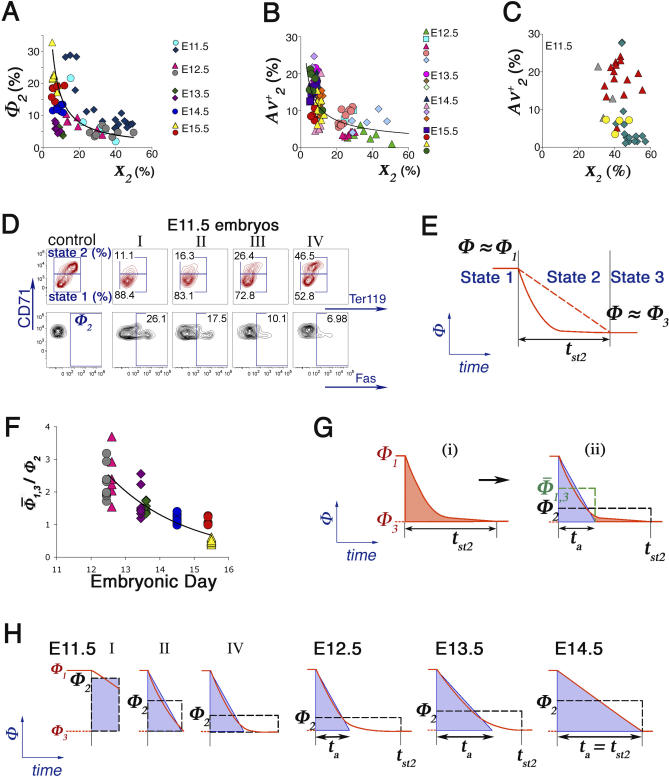
The Rate of FAS-Mediated Apoptosis in State 2 Is Proportional to x
2
2
(A) The fraction of FAS+ cells in state 2 (Φ2) is inversely proportional to the fraction of all fetal liver cells that are in state 2 (x
2). Each point represents an individual embryo from the same set of embryos shown in Figure 4D. The curve describes the equation y = 162x−
1.009 (R
2 = 0.63).(B and C) The fraction of ANXA5+ cells in state 2 (Av+
2) is inversely proportional to x
2 between E12.5 and E15.5 (B), but not in earlier E11.5 embryos (C). Each point represents an individual embryo from the same set of embryos and with the same symbols as in Protocol S2, section 2.3. The curve describes the equation y = 0.03x−
0.6 (R
2 = 0.4).(D) Four E11.5 embryos from the same litter, showing the distribution of cells in states 1 (x
1) and 2 (x
2) in the top panels, and a fraction of state 2 cells that are FAS+ (Φ2) in the lower panels. Staining control for FAS shown in the leftmost panels. See additional data on these in Protocol S2, section 2.4.(E) Potential time course of Φ, the fraction of cells that are FAS+, in a cohort of erythroblasts traversing state 2. t
st2 is the length of state 2. Φ1 and Φ3 are used as estimates for Φ when cells enter and exit state 2, respectively. The dashed red line represents a constant rate of decline in Φ throughout state 2. The solid red curve represents an alternative time course, with an initial rapid decline in Φ that slows down due to depletion of FAS+ cells.(F) Comparison of Φ2 with
Φ1,3, the arithmetic mean of Φ1 and Φ3, during E12.5 and E15.5. Data calculated for each embryo from values shown in Figure 4D. If the rate of decline in Φ in state 2 were constant, the ratio
Φ1,3/Φ2 would be expected to be equal to one. Since
Φ1,3/Φ2 is greater than one for embryos younger than E14.5, the rate of decline in Φ in these embryos resembles the solid red curve in (E).
(G) Approximate method for relating Φ2 to
Φ1,3 when the rate of decline in Φ is nonlinear. Φ2 equals the area under the red Φ curve (shaded red, panel i) divided by t
st2, and may be represented as the height of a rectangle (black dashed lines, panel ii) of height Φ2 and base t
st2. The shaded red area is approximately equal to the area of a triangle (shaded blue, panel ii) of base t
a, where t
a is the length of time within state 2 when the rate of decline in Φ is relatively constant. The area of the blue triangle, given by
Φ1,3
t
a, is therefore approximately equal to the area of the black dashed rectangle: Φ2
t
st2 =
Φ1,3
t
a
.
(H) Graphical representation of Φ2 and how it relates to the rate of decline in Φ. At E11.5, Φ declines rapidly as the first cohort of erythroblasts progresses through state 2, as suggested by data in (A) and (D). At E12.5–E13.5, Φ declines sufficiently rapidly so that it plateaus prior to completion of state 2, as suggested by (F). By E14.5, the rate of decline has slowed down and remains constant throughout state 2. Throughout, Φ2 is directly proportional to t
a (from [G]), and both are inversely related to x
2 (from [A], and see text).